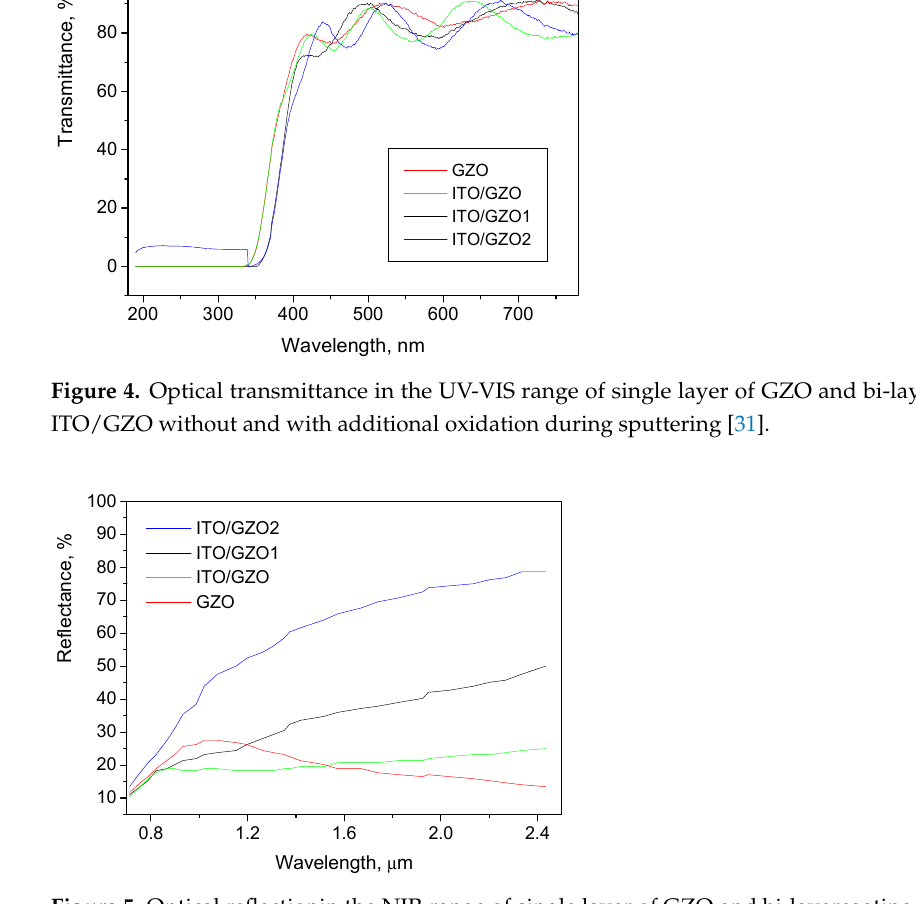
Figure 5. Optical reflectionin the NIR range of single layer of GZO and bi-layercoatings ITO/GZO without and with additional oxidation during sputtering [31].